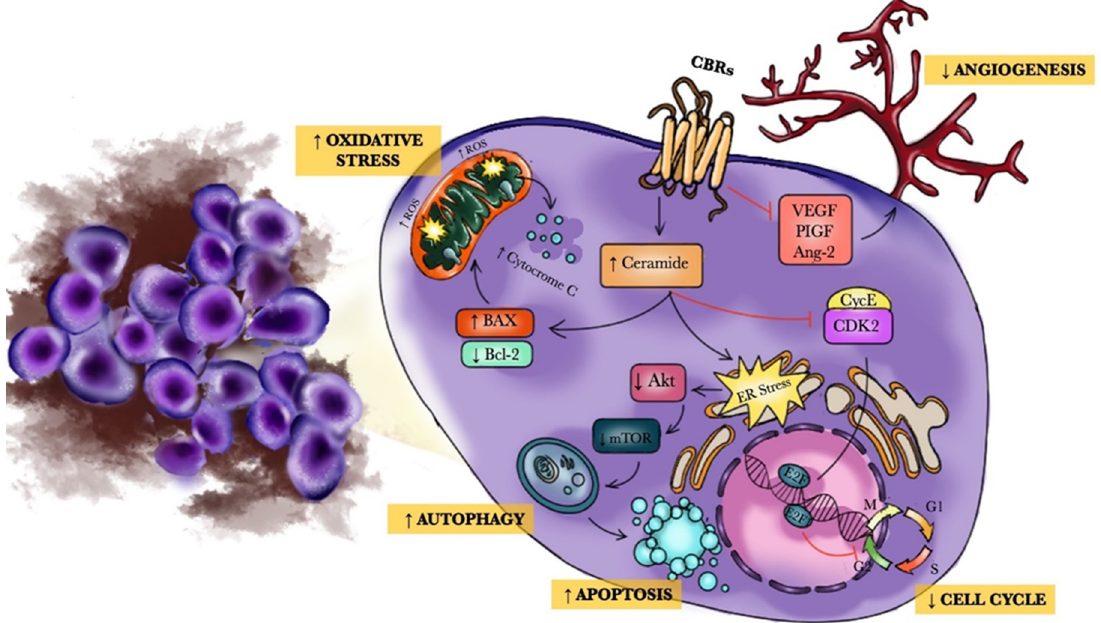
Figure 1. Antitumor mechanisms of CBs.CBs have a pro-apoptotic effect via an action on apoptosis regulators (Bcl-2 and BAX) as well as an effect on oxidative stress. CBs stimulate ceramide generation and cell death in tumor cells but not in normal cells, reduce angiogenesis, and exert an antiproliferative effect acting on the AKT/mTOR pathway. Finally, CBs can stimulate ER stress, thus stimulating both an AMP-activated protein kinase and the calcium/calmodulin-dependent protein kinase, kinase 2, which in turn activates autophagy. Abbreviations: CBs: Cannabinoids; BAX: bcl-2-like protein 4; Bcl-2: B-cell lymphoma 2; VEGF: vascular endothelial growth factor; Ang-2: Angiopoietin-2; PIGF: placental growth factor; AKT/mTOR: Protein kinase B/mechanistic target of rapamycin; ER: Endoplasmic reticulum.